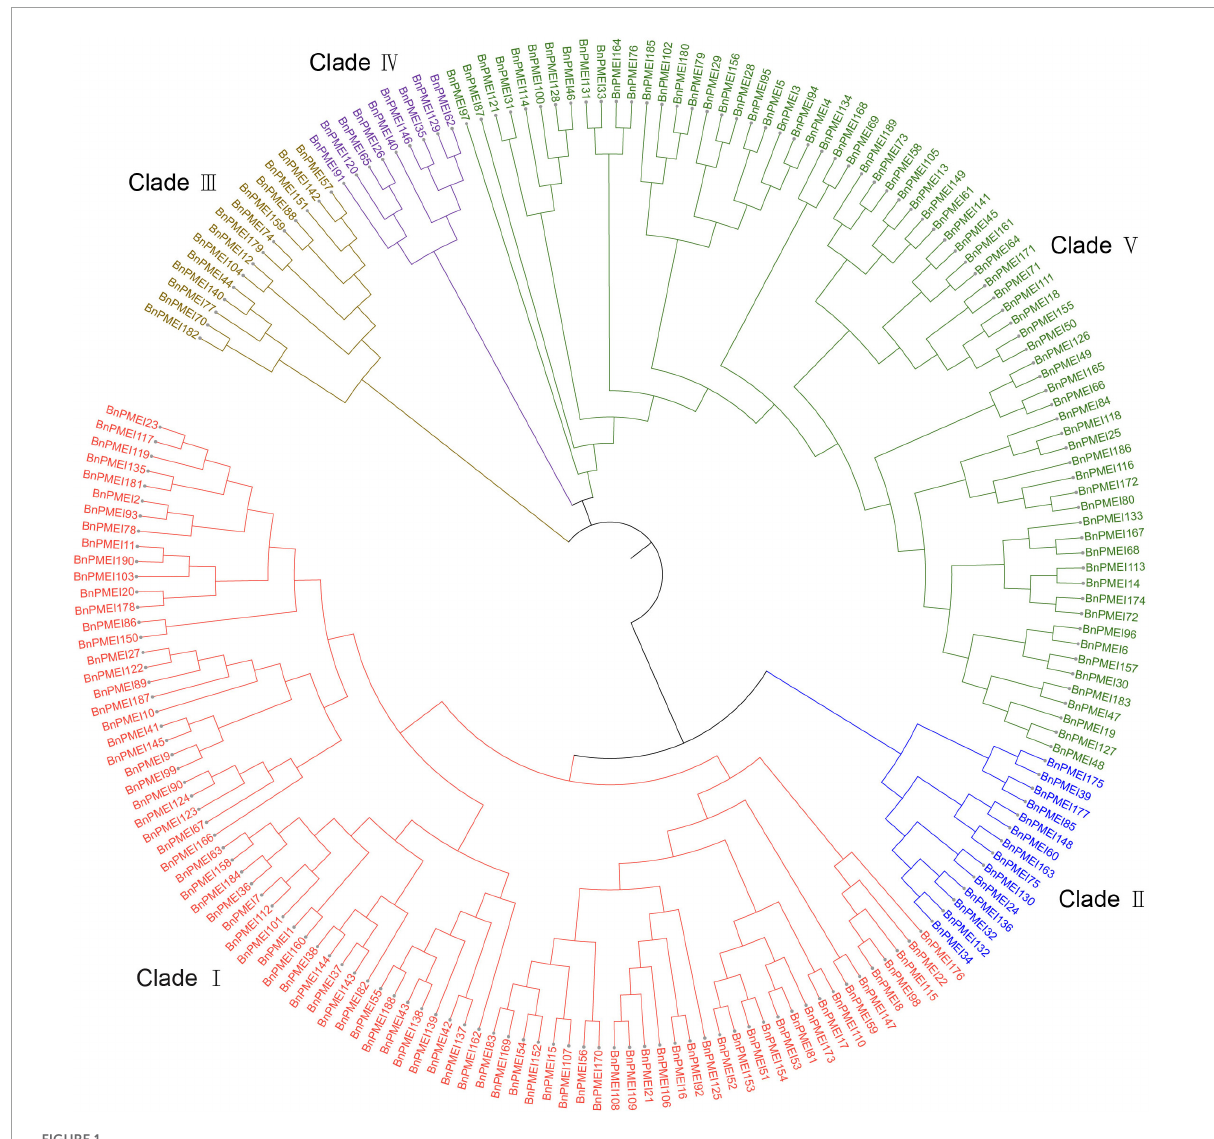
FIGURE1 Phylogenetic tree of PMEI proteins in B. napus . The maximum likelihood (ML) tree was constructed using MEGA11 with full-length amino acid sequences of 190 BnPMEIs, and the bootstrap replicate was set as 1000 times. Different clades of PMEI family were represented by different